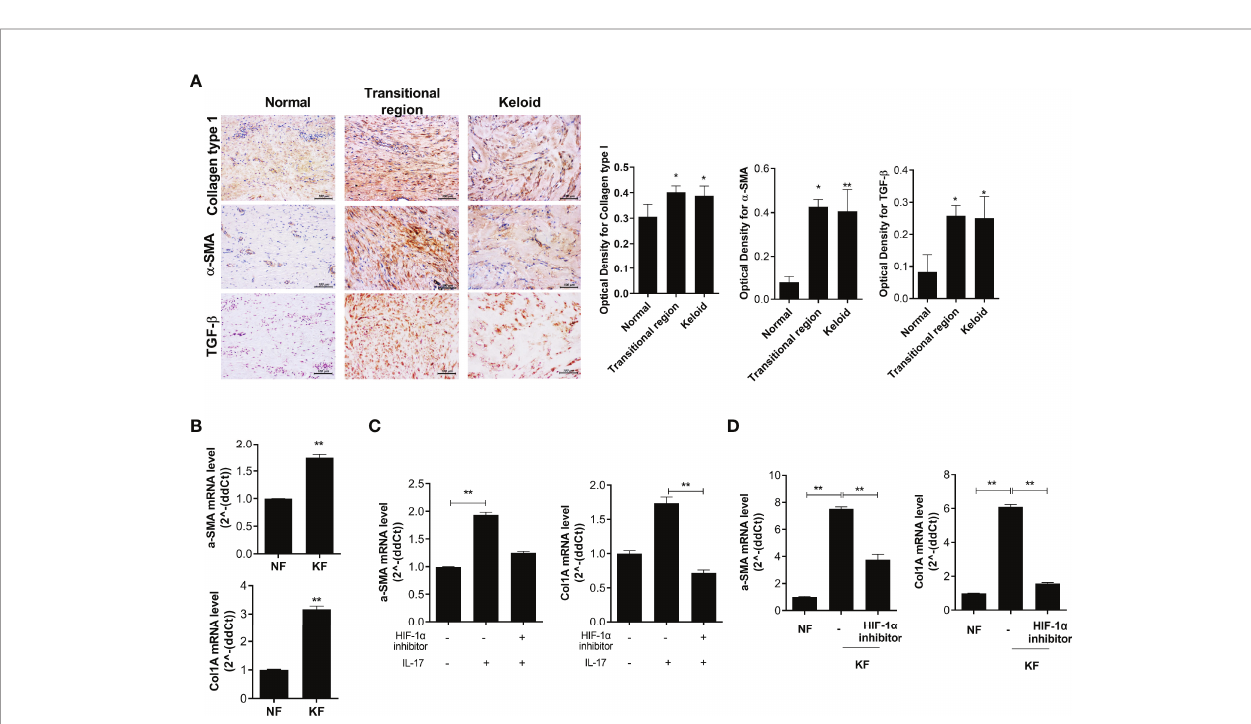
FIGURE 5 | Fibrosis was suppressed by HIF-1 a inhibition in KF. (A) COL1-, a -SMA-, and TGF- b -positive cells in keloid tissue were analyzed by IHC. (B) mRNA levels of a -SMA and Col1A in NF and KF. (C, D) mRNA levels of a -SMA and COL1A were analyzed in IL-17- and HIF-1 a inhibitor-treated NF or NF and HIF-1 a inhibitor-treated KF. Bar graph shows data from one of three independent experiments; results are means ± SD of three independent experiments per group (* P < 0.05, ** P <